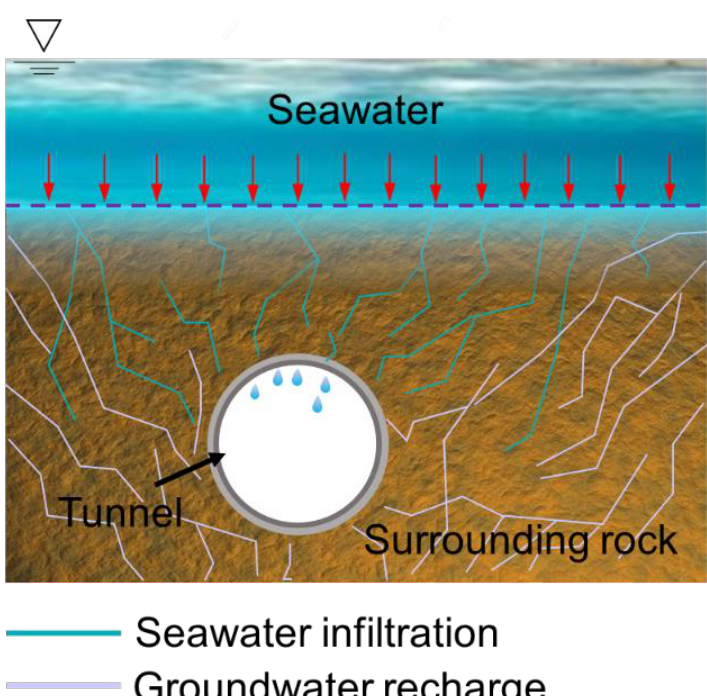
Figure 6. Tunnel water supply.